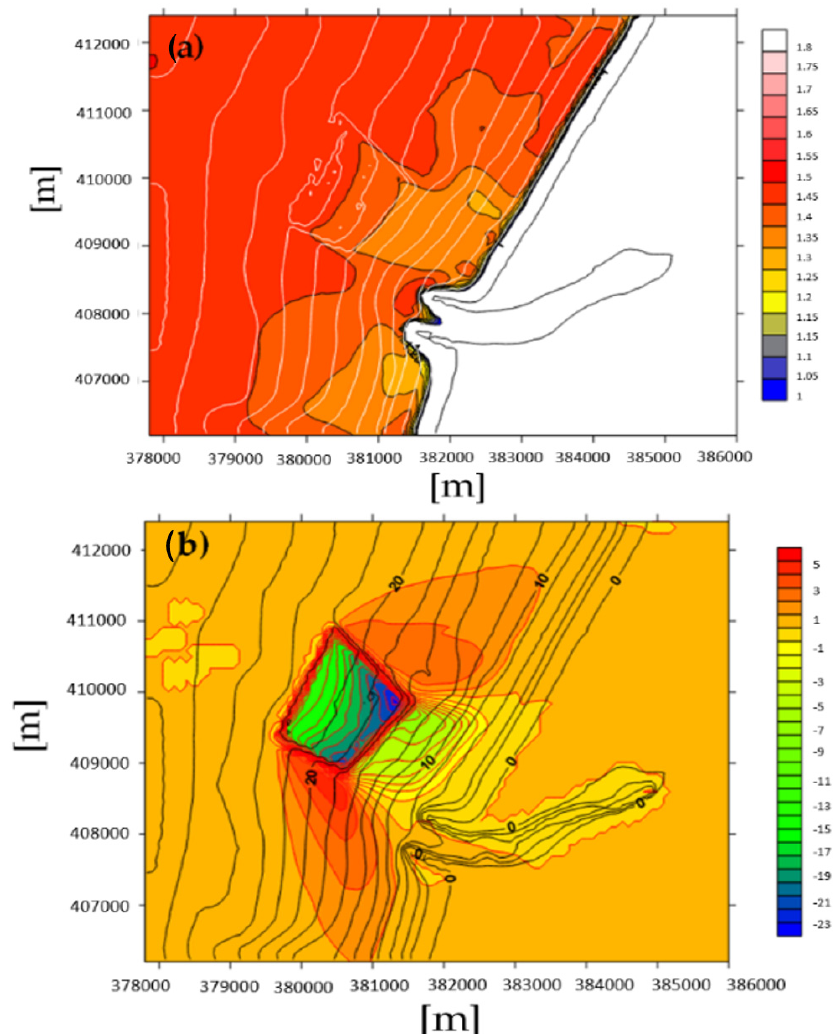
Figure 10. Impact of dredging 4 m-deep with ( H s0 = 1.5 m, T p = 8 s) ( a ) significant wave height distribution after dredging, ( b ) relative friction velocity at the seabed after dredging up to 2 m depth. The legends indicate the values of H s in meters and those of relative friction velocity in [cm/s]. The contour lines indicate the bathymetry values.